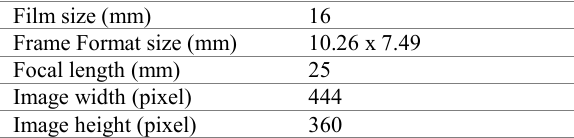
Table 1. Specifications of video frames